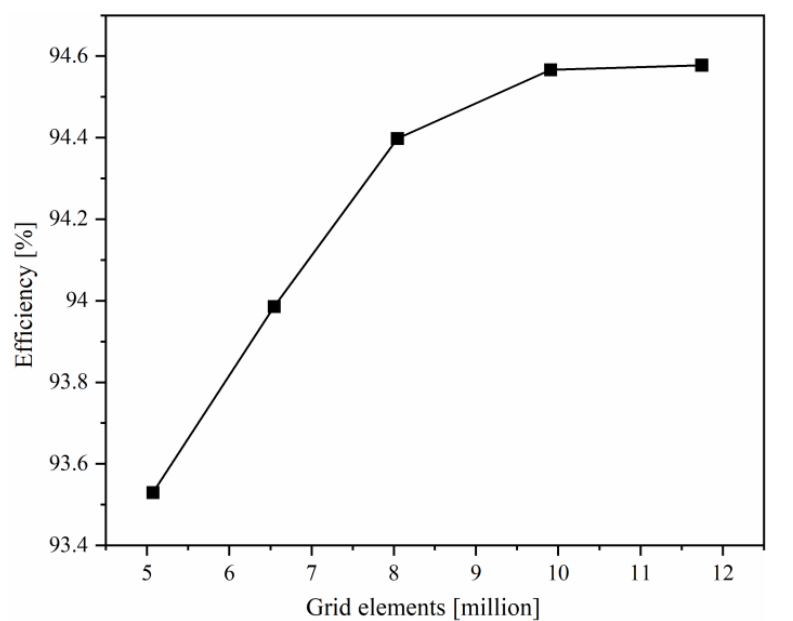
Figure 4. Grid independence verification.